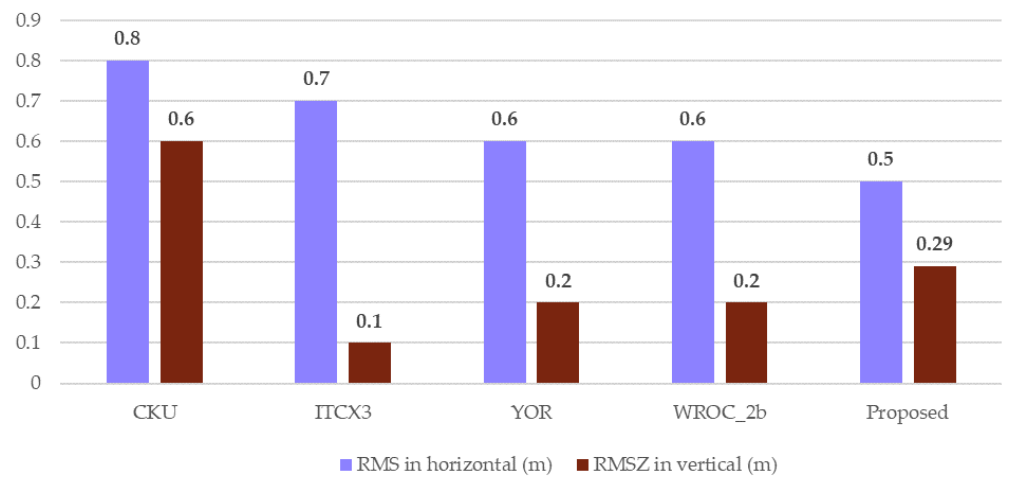
Figure 23. Comparison of the geometrical accuracy of the four-state-of-art reconstruction methods.